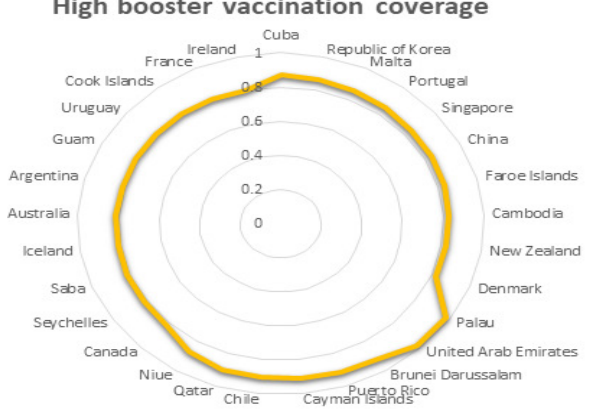
Figure 8. The booster vaccination rates of 24 countries with low vaccination rates.